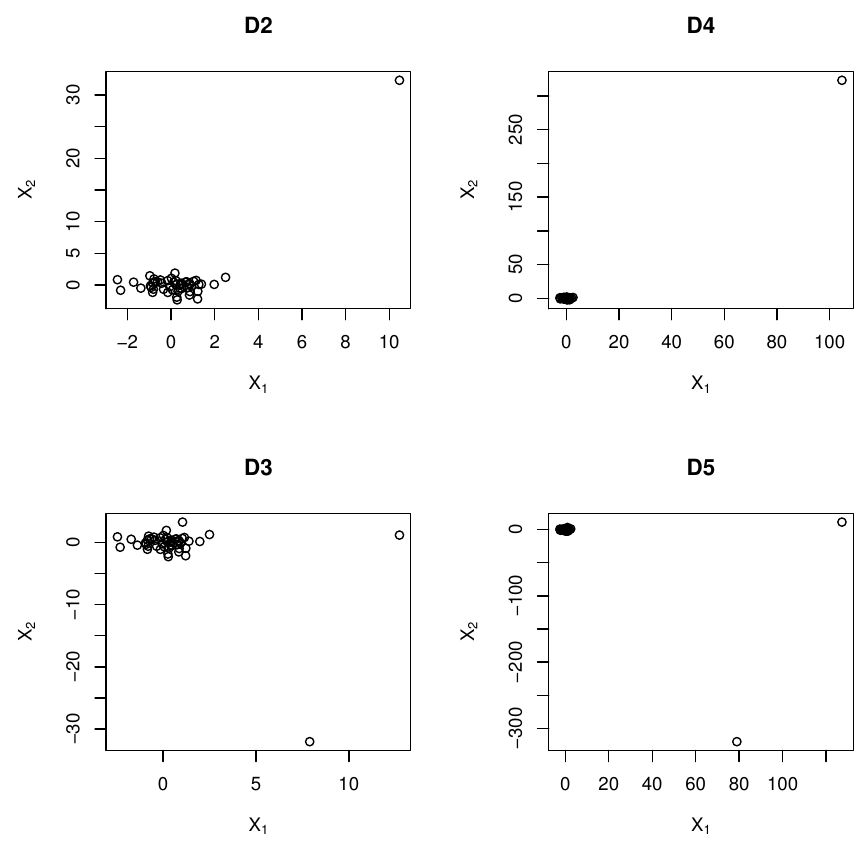
Figure 1. Collinearity influential points. First row panel shows boxplots for collinearity induc- ing points in D 2 and D 4, and second row panel shows boxplots for collinearity masking points (collinearity hiding points) in D 3 and D